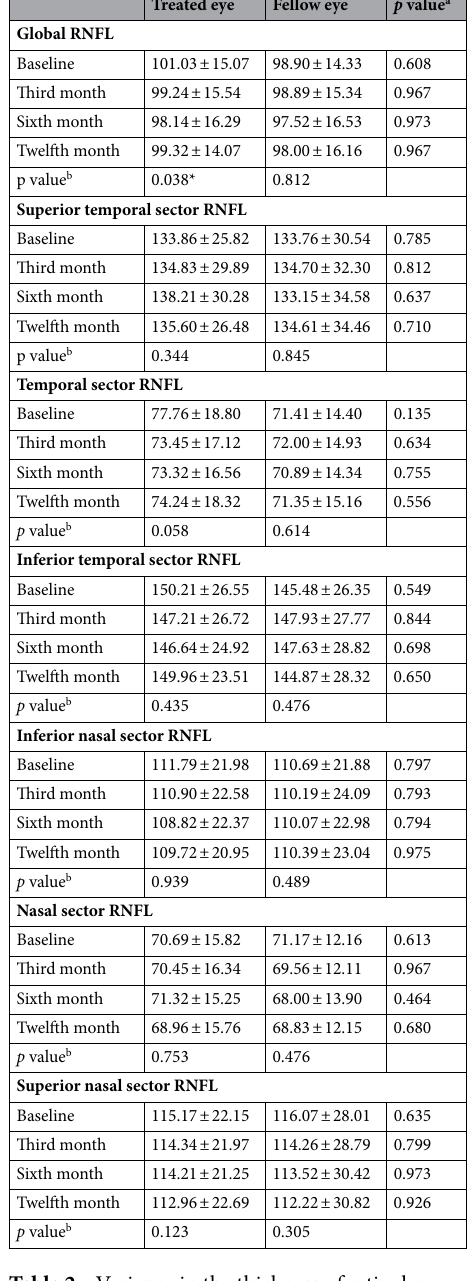
Table 2. Variance in the thickness of retinal nerve fiber layer (μm) in the group administered intravitreal ranibizumab injection. RNFL retinal nerve fiber layer. a Comparison between the treated and fellow eyes in each period (Mann–Whitney U -test). b Comparison between the baseline and twelfth month for each value (Wilcoxon signed-rank test). * p